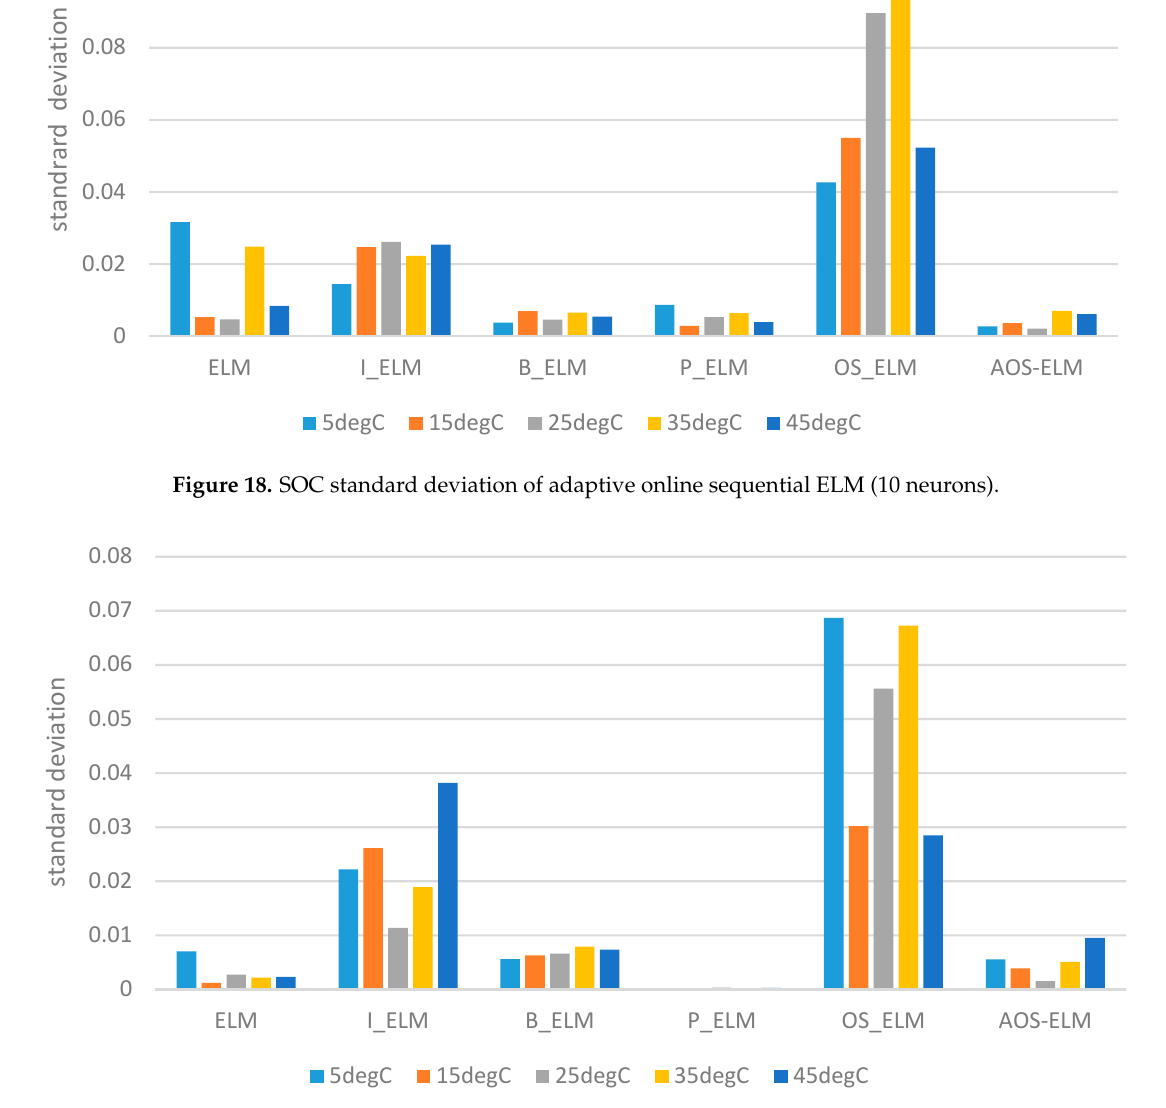
Figure 19. SOC standard deviation of adaptive online sequential ELM (20 neurons).